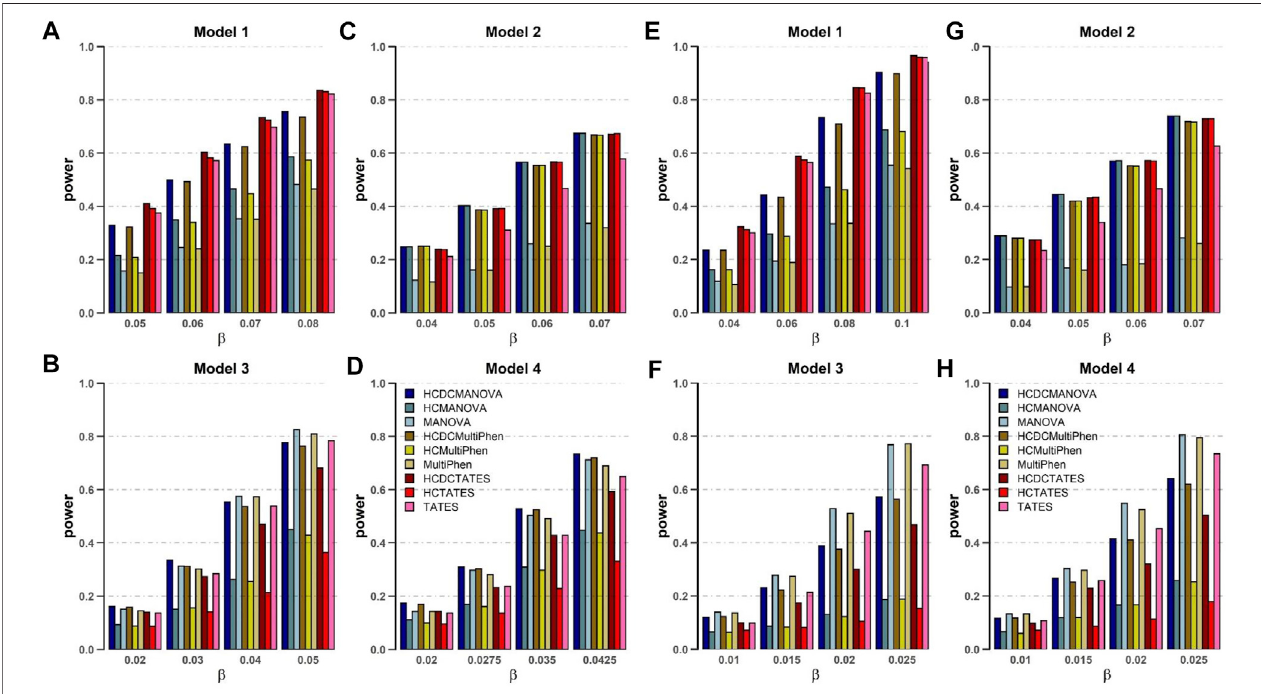
FIGURE1| Powercomparisonsoftheninemethodsasafunctionof β inthefourmodels.Samplesize N =2,000,thenumberofphenotypes M =16 (A – D) andM= 32 (E – H) , c 2 = 0.5, ρ c 2 = 0.1, and MAF = 0.3. The power of all the methods is evaluated by 1,000 replicated samples at a signi fi cance level of 0.05.